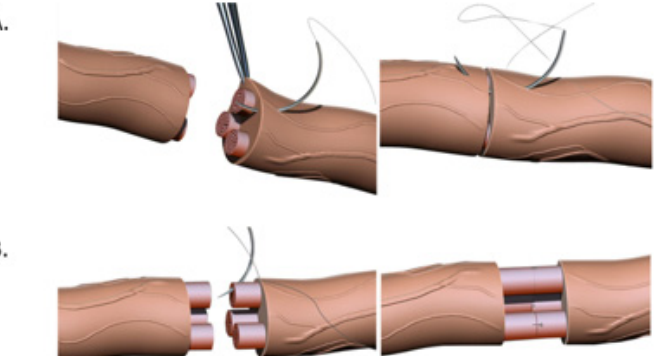
Figure 3. ( A ) . Nerve coaptation via epineural suturing technique demonstrating sutures in the epi- neurium. ( B ) . Nerve coaptation via fascicular repair demonstrating sutures in individual